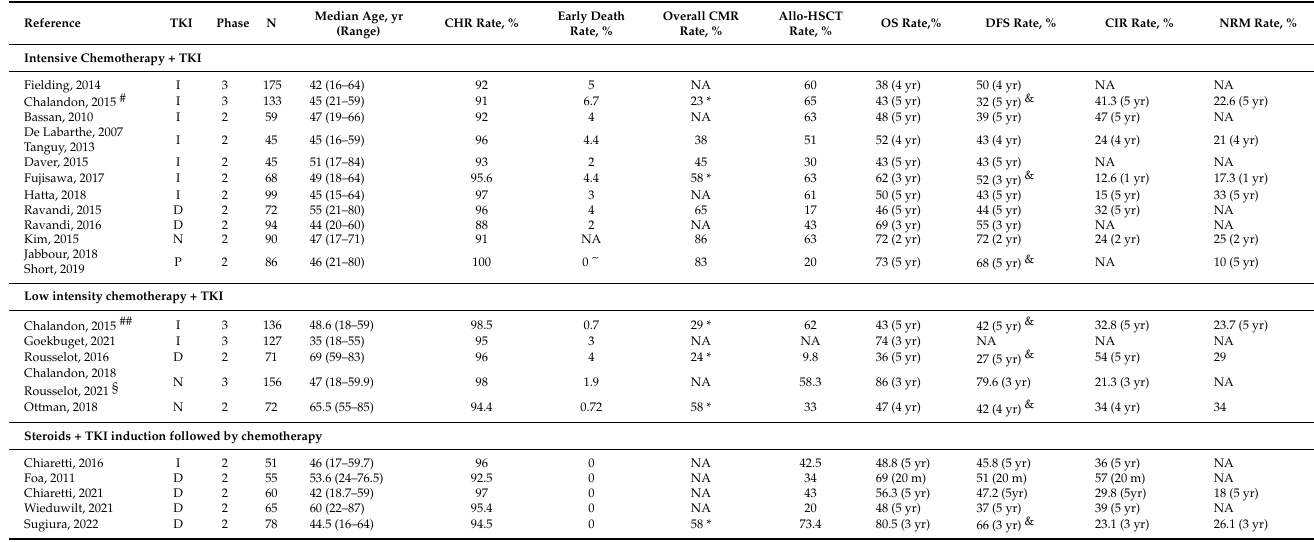
Table 1. Frontline trials of TKI-based regimens in adult Ph+ ALL